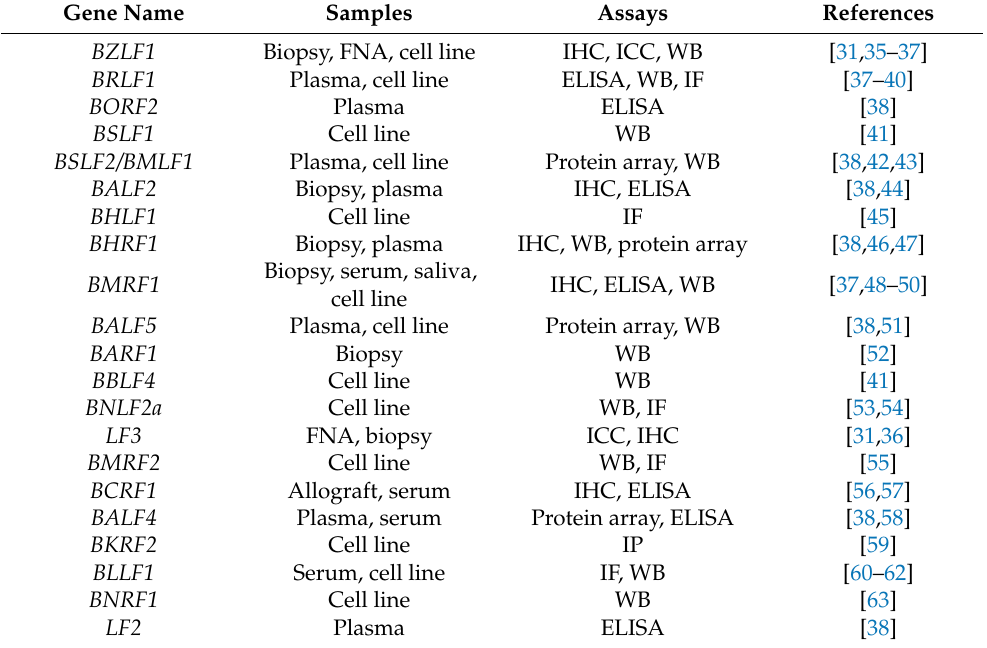
Table 2. Detection of proteins or antibodies against EBV lytic genes that are expressed in primary EBV-associated cancers by